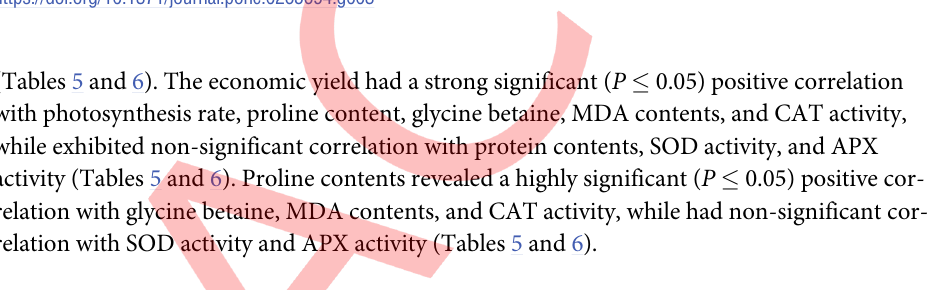
seed priming techniques.